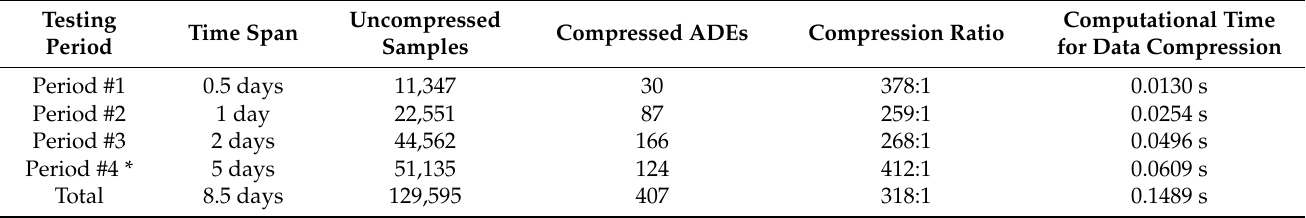
Table 3. Compression ratios and data compression